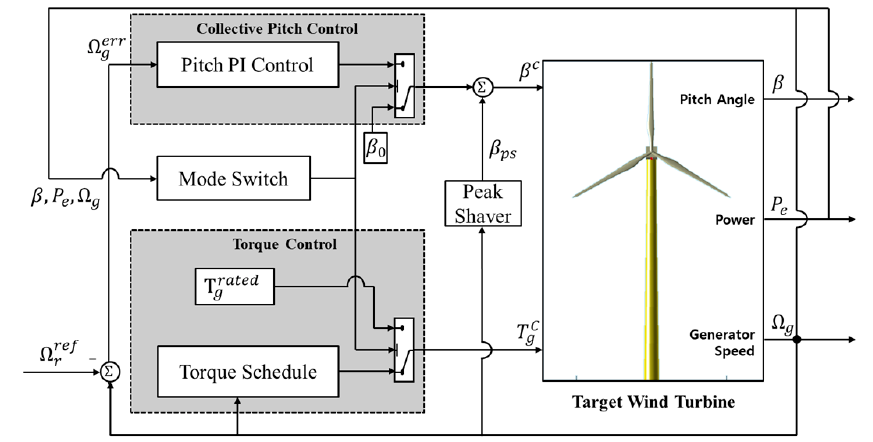
Figure 7. The wind turbine model control system.